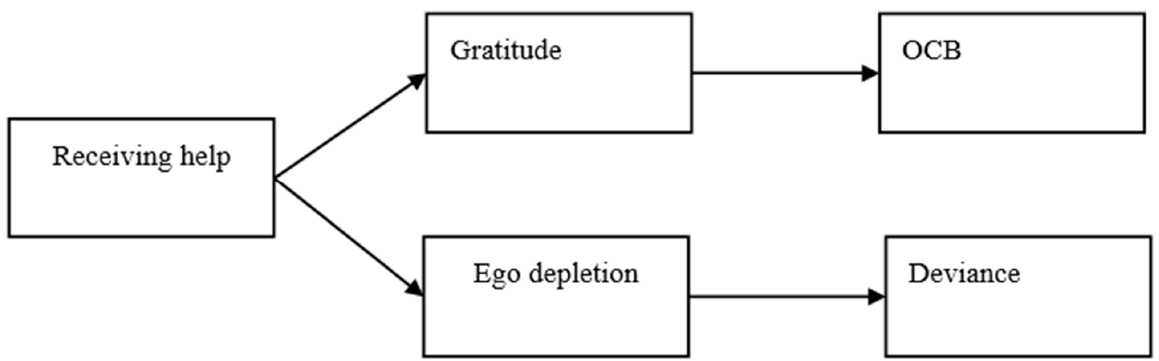
Figure 1. Overall conceptual model. OCB: organizational citizenship